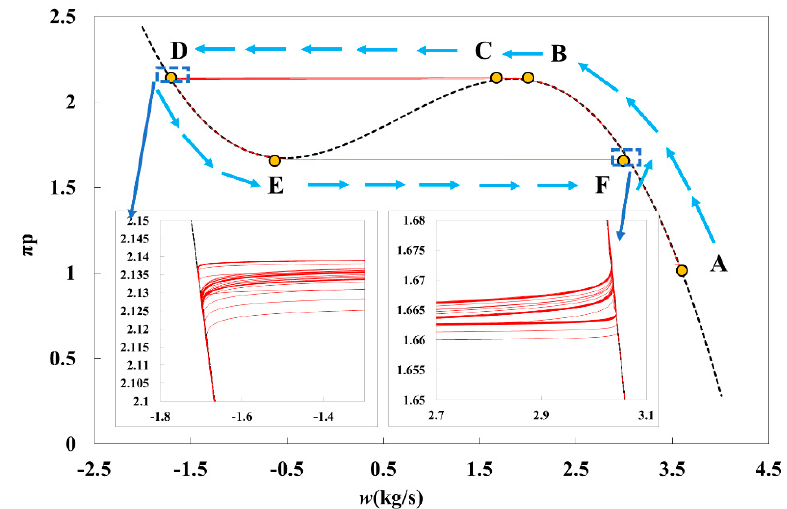
Figure 11. Compressor operating trajectory of the compression system with one throttle valve. Where the red solid line is the track of the migration of operating points, and the black dotted line is the compressor performance curve. The points “ABCDEF” are the key node for the change of compressor working condition. The blue shear head represents the direction of migration of working condition point during surge.